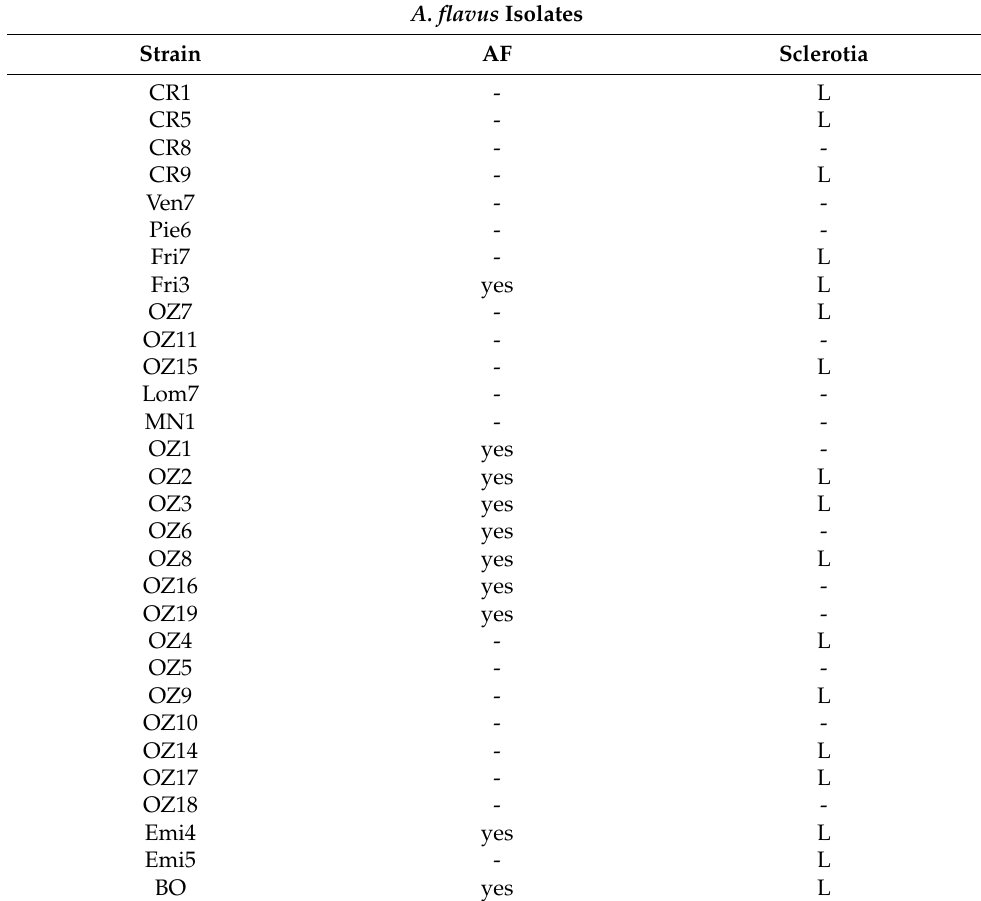
Table 1. Biological characterization of A. flavus isolates in terms of aflatoxin production (AF) and sclerotia biogenesis and type (L: large